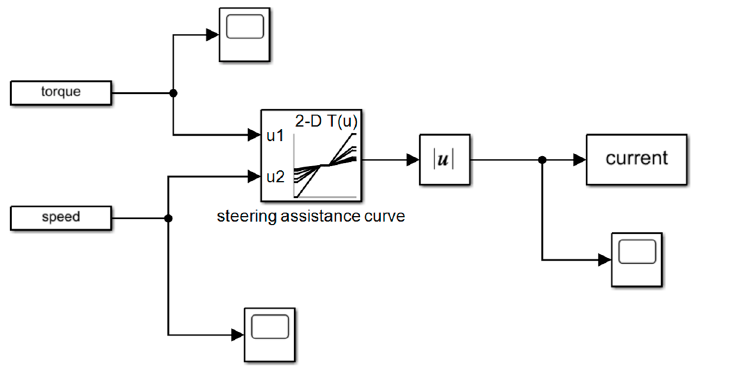
Figure 7. The assist characteristic model of EPS.